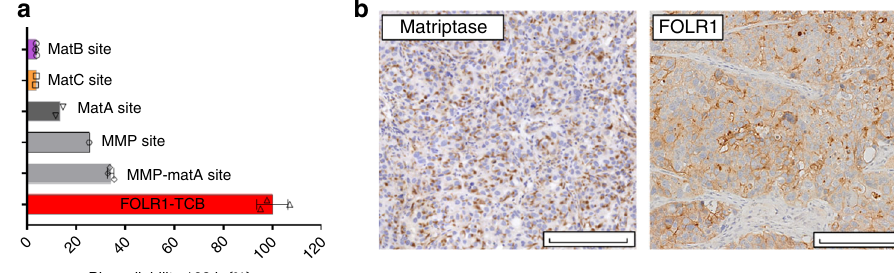
Fig. 8 Stability of Prot-FOLR1-TCB depends on the cleavage site. a Bioavailability of active Prot-FOLR1-TCB containing different cleavage sites at day 7 after intravenous single-dose injection in non-tumor-bearing NSG mice ( n = 3 per group). Active and total Prot-FOLR1-TCB were quanti fi ed by ELISA using an anti-PG-LALA antibody (total Prot-FOLR1-TCB) and the anti-idiotypic anti-CD3 antibody (active Prot-FOLR1-TCB). Pharmacokinetic evaluation was conducted by noncompartmental methods. Areas under the serum concentration − time curve were calculated by linear trapezoidal rule. Bioavailabilities F of the active FOLR1-TCB after Prot-FOLR1-TCB administration were calculated by comparing AUC 0 − 168 h values of FOLR1-TCB following i.v. administration of the respective pro-TCB (AUC from Prot-FOLR1-TCB) and administration of the active TCB (AUC FOLR1-TCB) according to F (%) = (AUC from Prot-TCB/AUC TCB)× 100. Dose corrections were not required, as equimolar doses of Prot-FOLR1-TCB and FOLR1-TCB were used in the respective studies. b Immunohistochemistry of FOLR1 and matriptase in breast PDX tumor at baseline. Some tumors were harvested at start of treatment for the baseline characterization of FOLR1 target antigen and matriptase by immunohistochemistry. Positive staining is observed as a brown precipitate within the sections. The evaluation of FOLR1 and Matriptase expression in the described in vivo model has been conducted twice in two independent samples. Scale bars indicates 200 µ m and is included in the